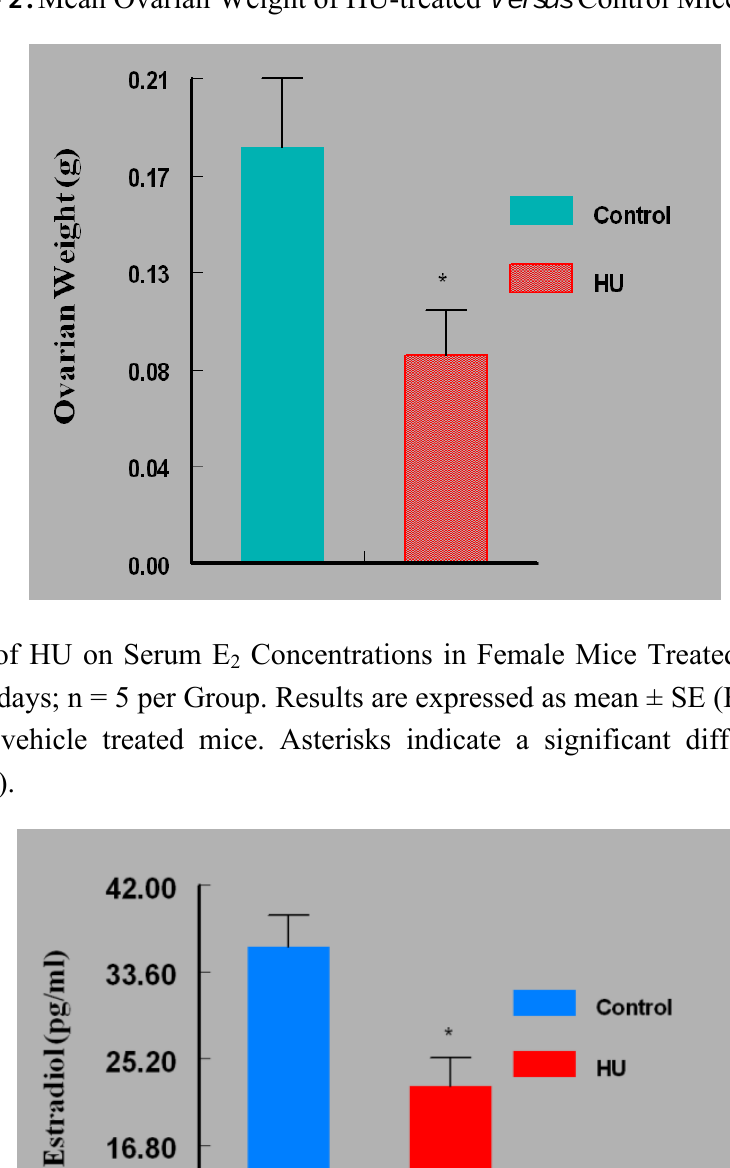
Figure 2. Mean Ovarian Weight of HU-treated Versus Control Mice.